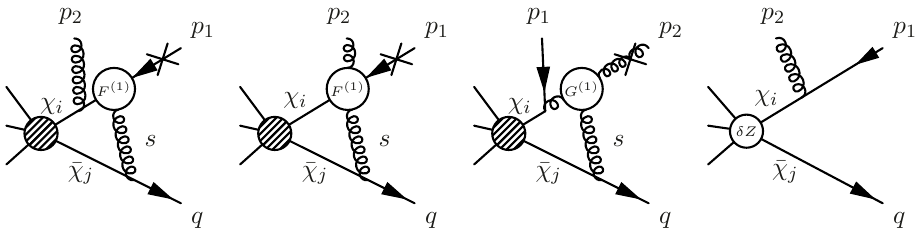
(cid:22) (cid:22) (cid:31) j (cid:31) i . Momenta are outgoing. ? i ! A